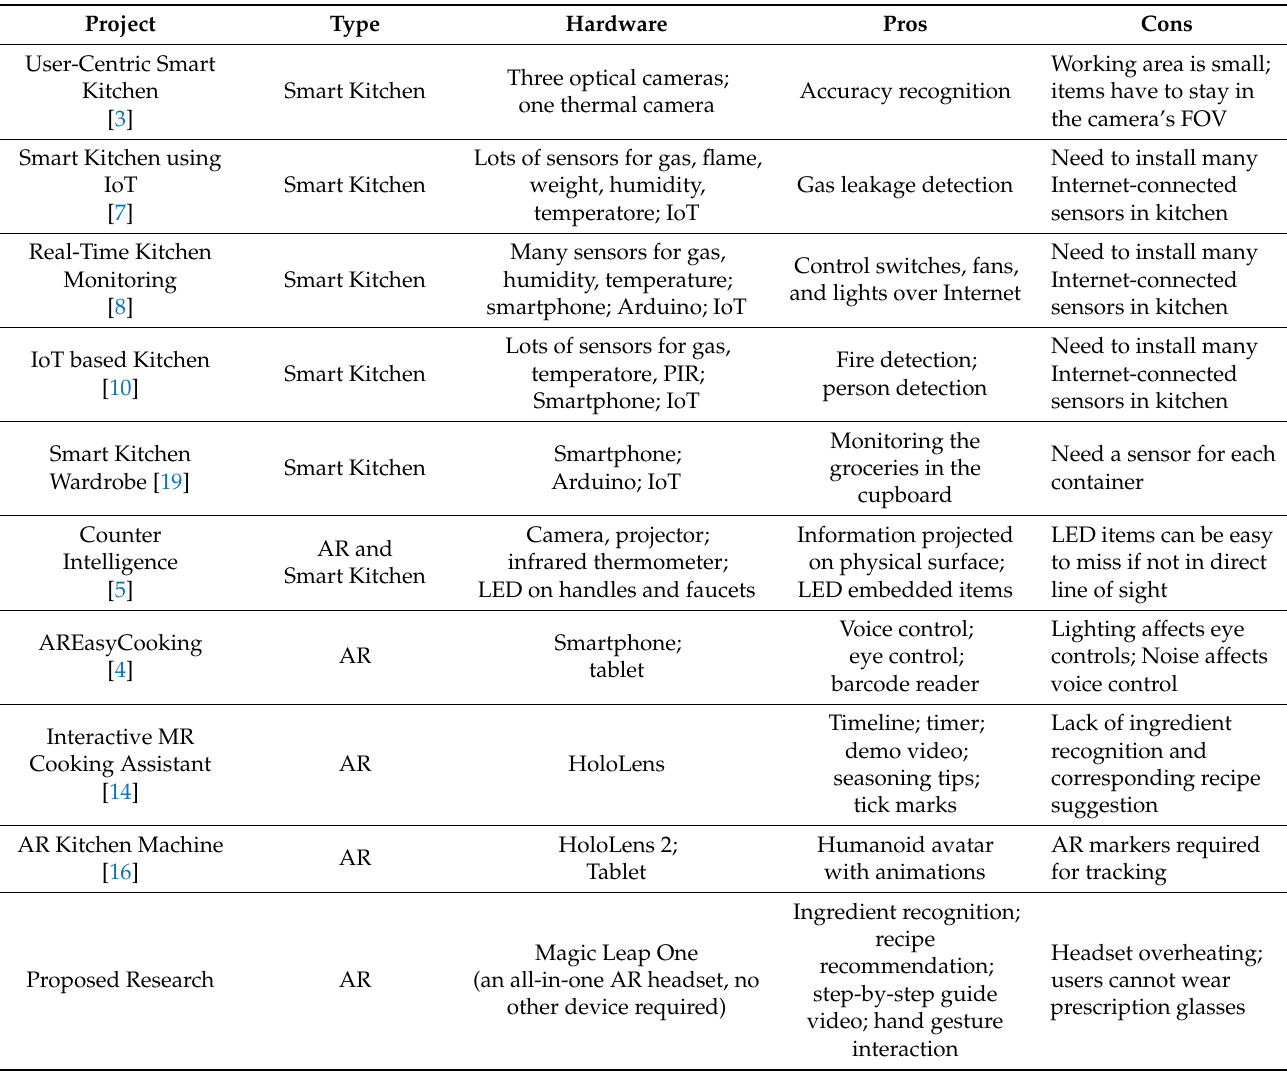
Table 1. Pros and cons of the proposed research and nine other related